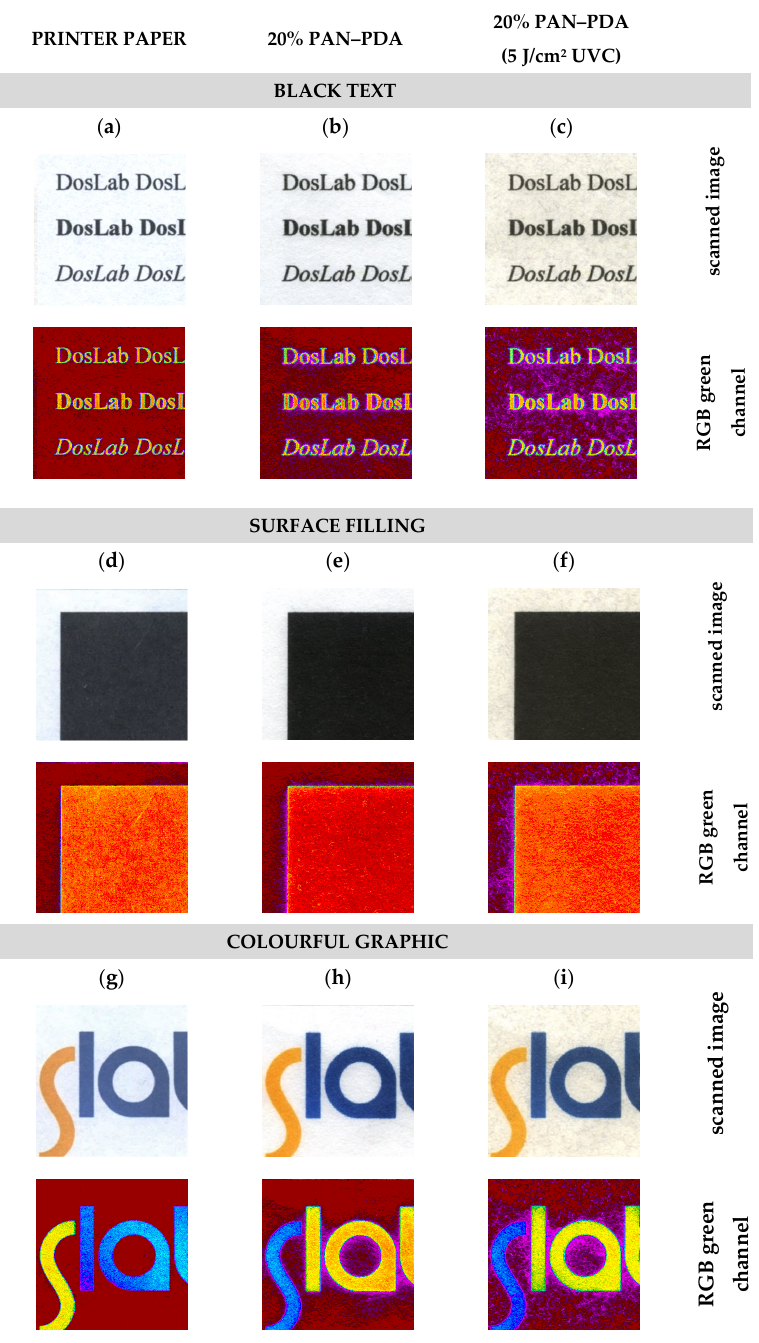
Figure 10. Comparison of printed patterns and print quality on the surface of paper samples: ( a , d , g ) commercial printer paper; ( b , e , h ) refined paper with 20% PAN–PDA fibres; ( c , f , i ) refined paper with 20% PAN–PDA fibres after irradiation (5 J/cm 2 UVC).